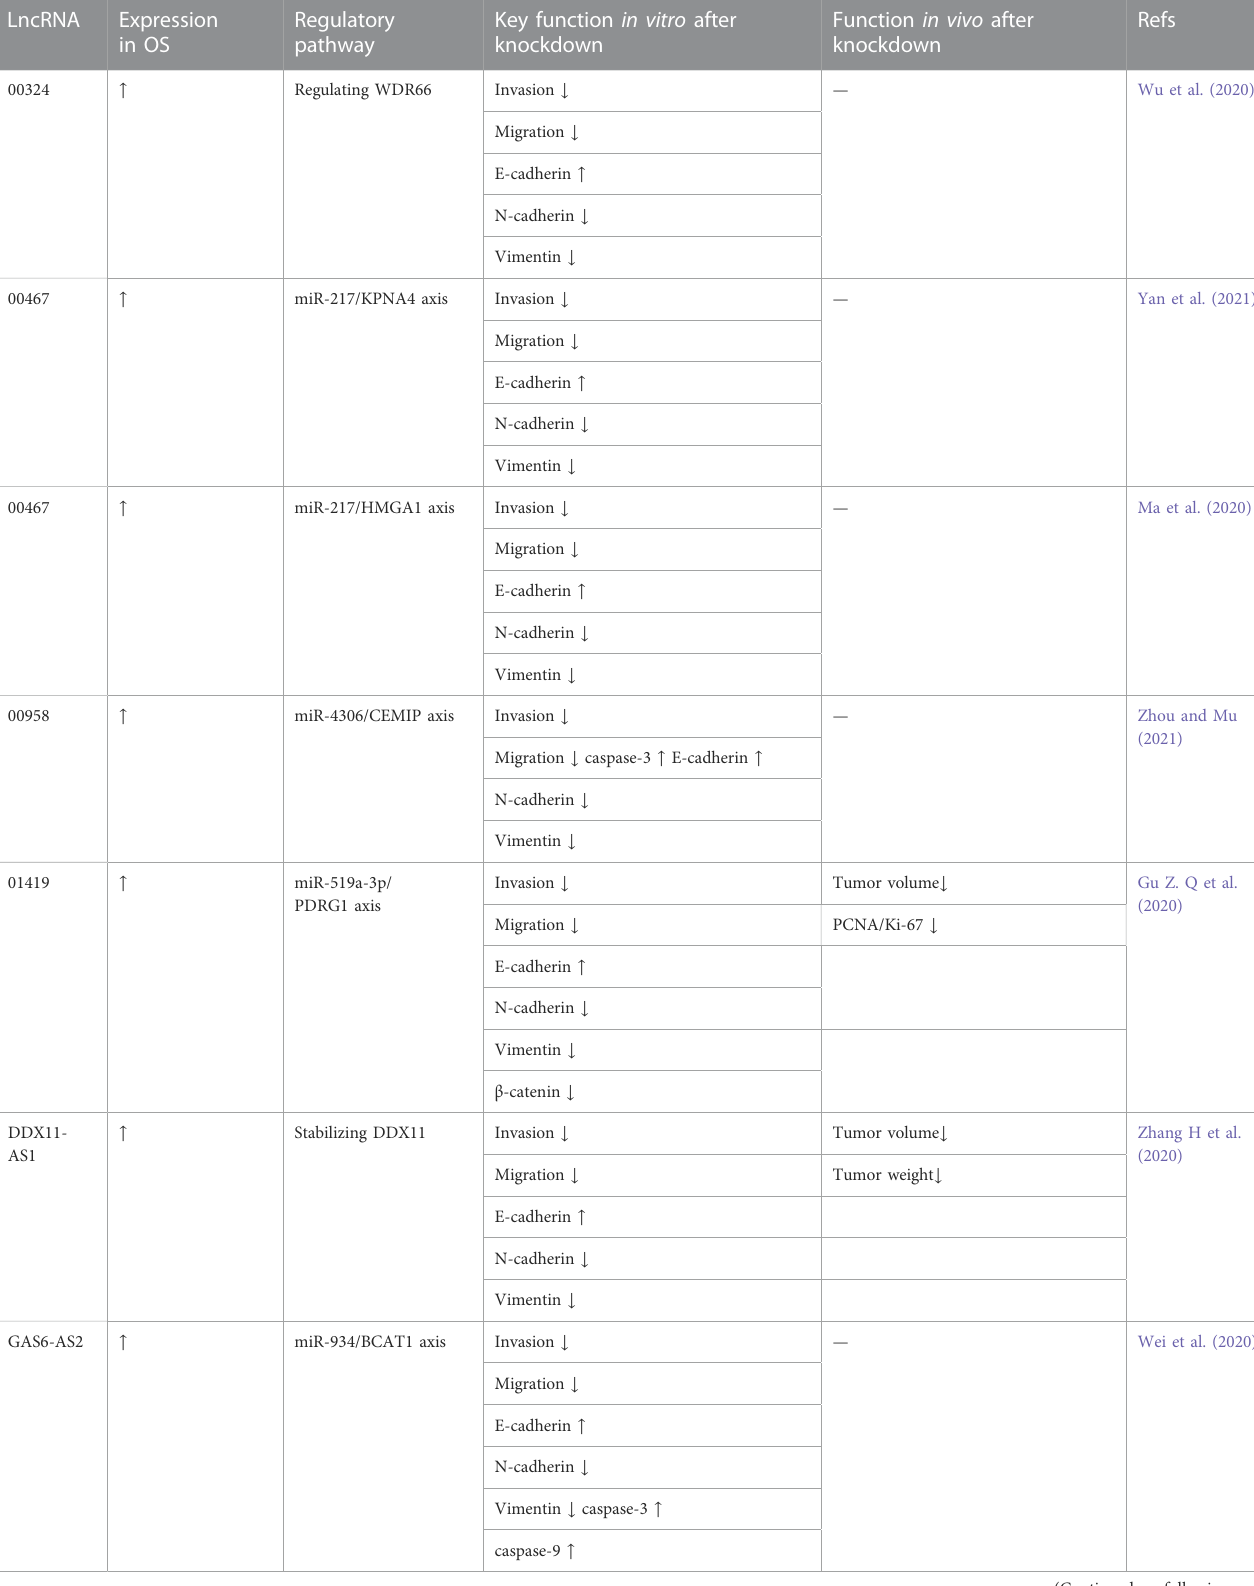
TABLE 5 Oncogenic lncRNA associated with the regulation of EMT-related protein expression in osteosarcoma